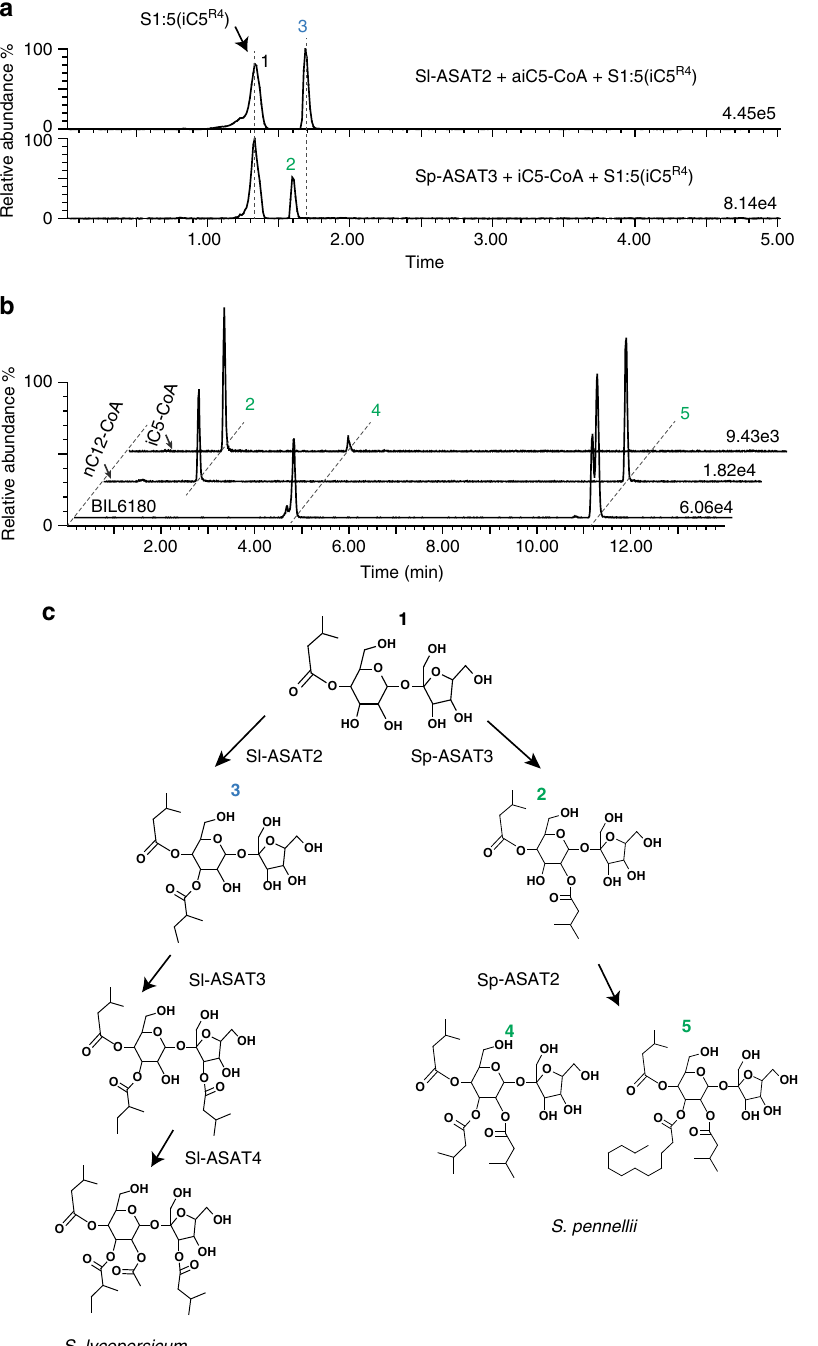
Fig. 3 Sp-ASAT2 and Sp-ASAT3 produce P-type acylsucroses via a “ fl ipped pathway ” . a S. pennellii LA0716 wild tomato Sp-ASAT3 acylates S1:5 (iC5 R4 ) and produces a diacylsucrose product (peak 2) with a retention time distinct from that made by cultivated tomato Sl-ASAT2 (peak 3). b Sp-ASAT2 converts the S2:10 (iC5 R2 , iC5 R4 ) diacylsucrose produced by Sp-ASAT3 (peak 2) to triacylsucroses with the same retention times as those produced by BIL6180 (peaks 4 and 5). “ iC5-CoA ” and “ nC12-CoA ” refer to the two different acyl donor substrates used in the two enzyme reactions. c The “ fl ipped ” acylsucrose biosynthetic pathways in S. lycopersicum and S. pennellii LA0716. The numbers on top of each compound refer to the chromatographic peaks